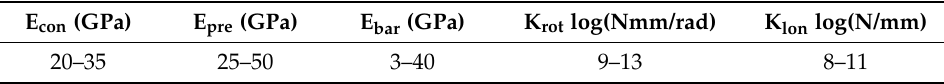
Table 1. Primary parameters considered and their initial